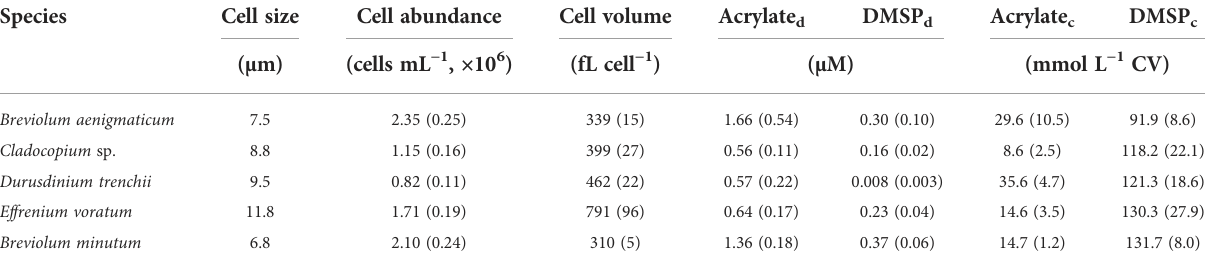
TABLE 2 Cell size and mean abundance, cell volume (CV), dissolved and cellular concentrations of acrylate and DMSP in fi ve non-axenic, batch cultures of known coral symbionts from the family Symbiodiniaceae. Species